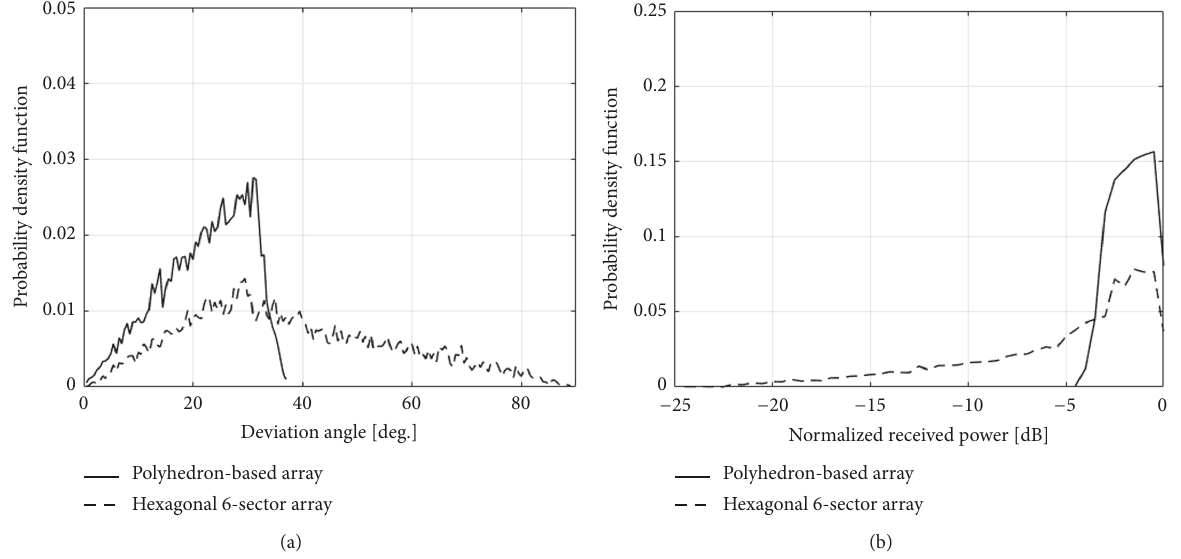
Figure 9: Performance for the 3D UE distribution: (a) deviation angles and (b) the received